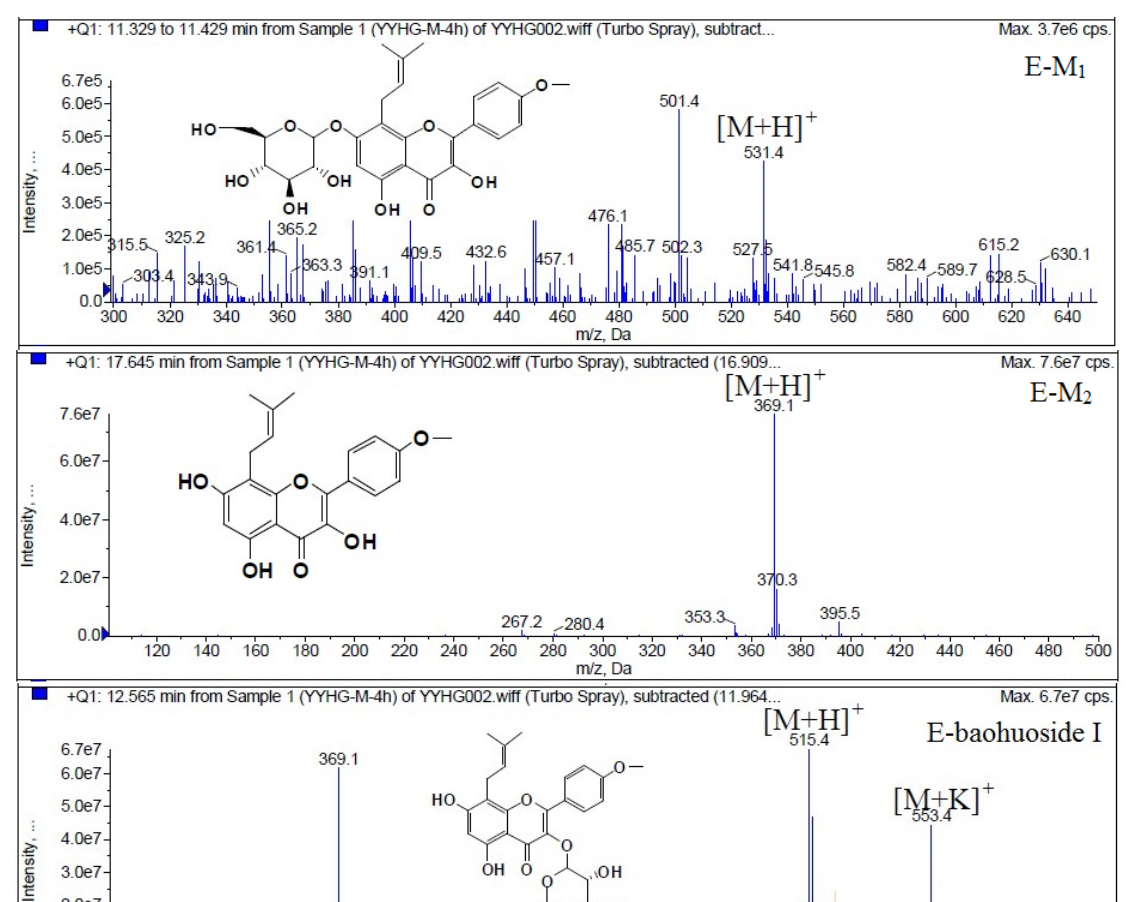
Figure 6. Mass spectra of metabolite of icariin. E for metabolites in intestinal enzyme; F for metabolites in intestinal